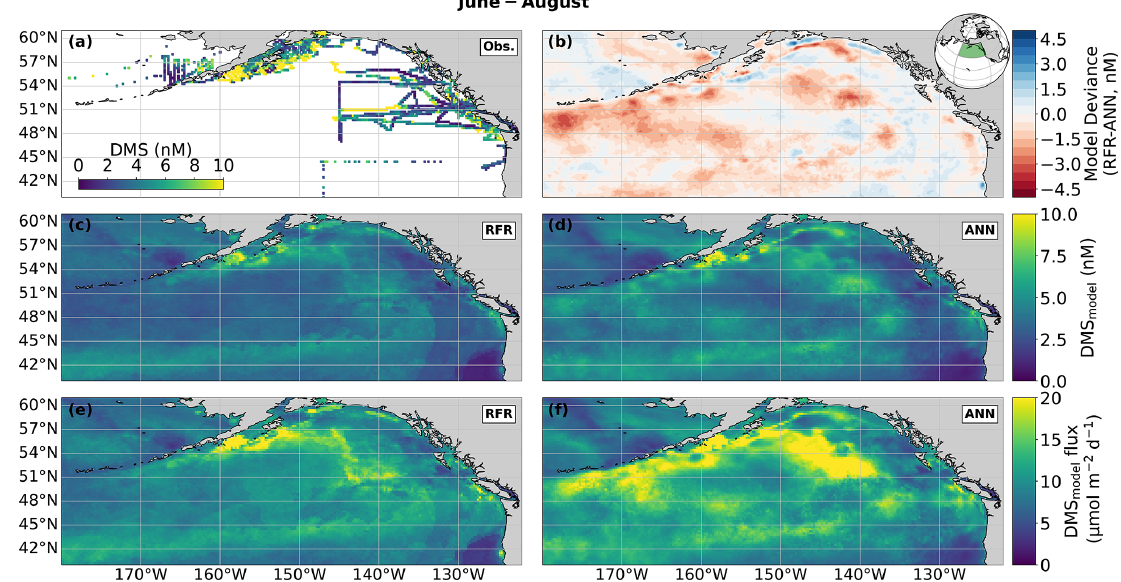
Figure 4. Predicted maps of sea surface DMS concentrations and sea–air fluxes. (a) Ship-based observations of mean summertime (June– August) DMS concentrations used to construct the predictive models. (b) Differences between the (c) random forest regression (RFR) and (d) artificial neural network (ANN) ensemble-predicted DMS concentrations. (e, f) DMS sea–air fluxes derived from the predicted DMS concentrations. Colormap ranges are restricted to illustrate trends, with < 1% of DMS data exceeding the colorbar limits. The inset map in (b) shows the NESAP study region as a shaded green patch in a global orthographic projection. Table 3. Monthly and mean summertime NESAP sea–air DMS fluxes. Total cumulative fluxes of DMS-derived sulfur (Tg, mean ± SD) are calculated from the random forest regression (RFR) and artificial neural network (ANN) model predictions (based on an ensemble of 2000 models). Total cumulative NESAP sea–air flux derived from the Lana et al. (2011) climatology is shown for comparative